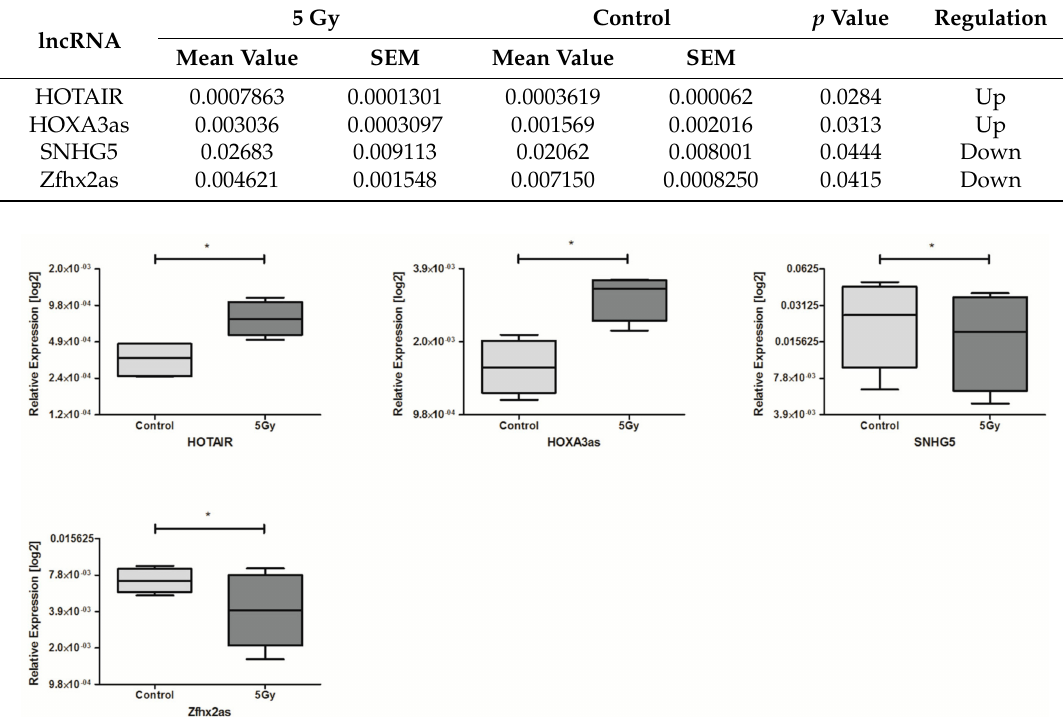
Figure 2. Differences in lncRNAs expression: HOTAIR, HOXA3as, SNHG5, and Zfhx2as in HNSCC cell lines after exposure to 5 Gy irradiation. Paired t -test; the graphs show relative expression, mean value with standard error of mean (SEM); * p < 0.05.